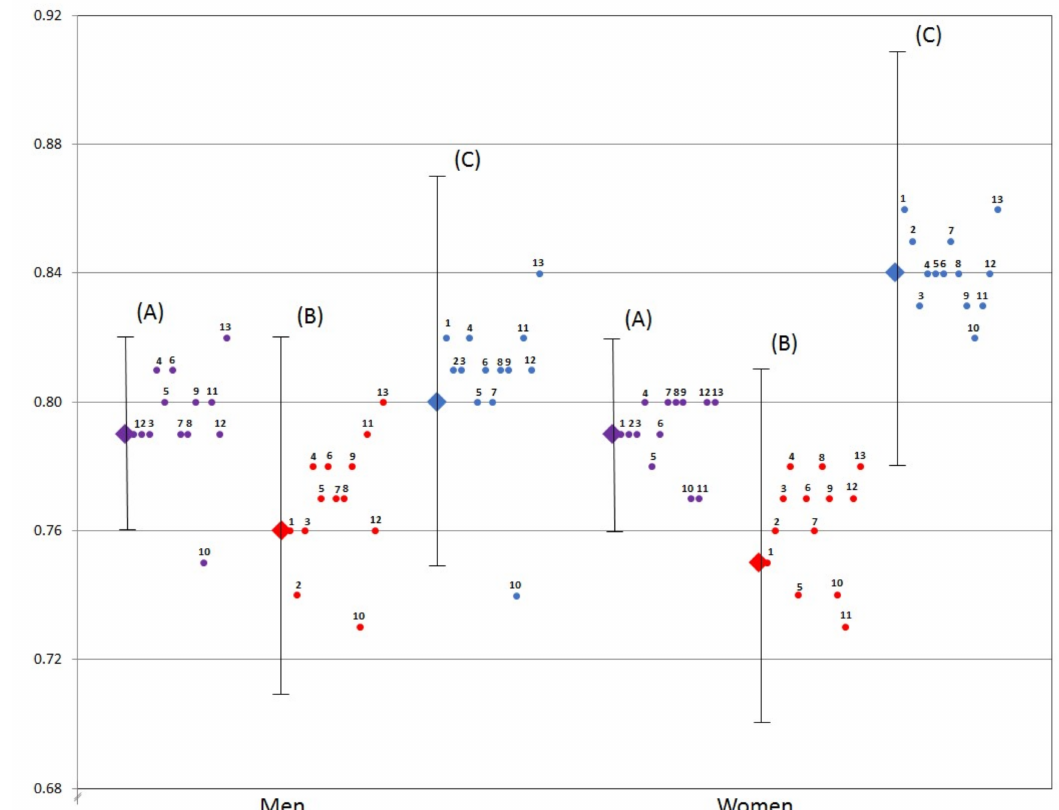
Figure 1. Quintile 1: quintile 5 hazard ratios (HR) and 95% confidence intervals (CI) for all-cause, cardiovascular disease (CVD) and cancer mortality for Healthy Eating Index-2015 (HEI-2015) scores with one component removed for men and women in the Multiethnic Cohort. Diamond shapes represent HR for mortality by ( A ) all-cause (purple), ( B ) CVD (red) and ( C ) cancer (blue) for men and women, as per results shown in Table 3. Smaller dots represent HR for HEI-2015 with one component removed. When excluded, the component is labeled as: (1) Total Fruits, (2) Whole Fruits, (3) Total Vegetables, (4) Greens and Beans, (5) Whole Grains, (6) Dairy, (7) Total Protein Foods, (8) Seafood and Plant Proteins, (9) Fatty Acids, (10) Refined Grains, (11) Sodium, (12) Added Sugars, (13) Saturated Fats. All models were adjusted for self-reported covariates; age at study entry, body mass index, history of diabetes, energy, ethnicity, education, marital status, smoking, weekly hours of moderate to vigorous physical activity, and alcohol intake. All models for women were also adjusted for hormone replacement